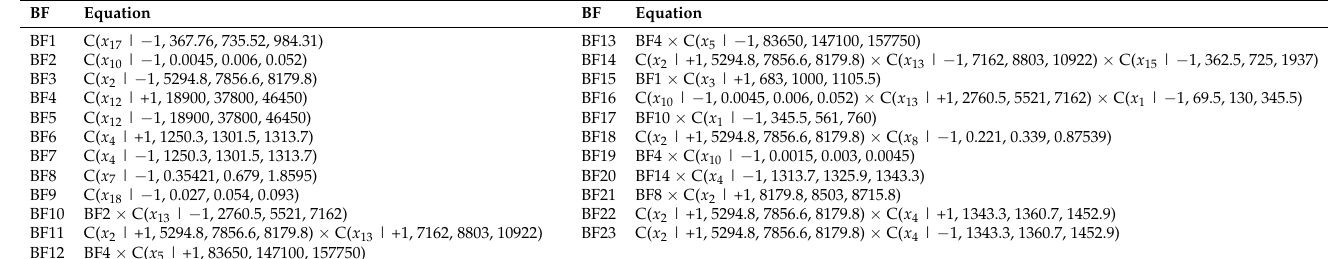
Table 12. Basis functions of the piecewise-cubic MARS model of melt temperature (lime and dolomitic lime added as supplementary